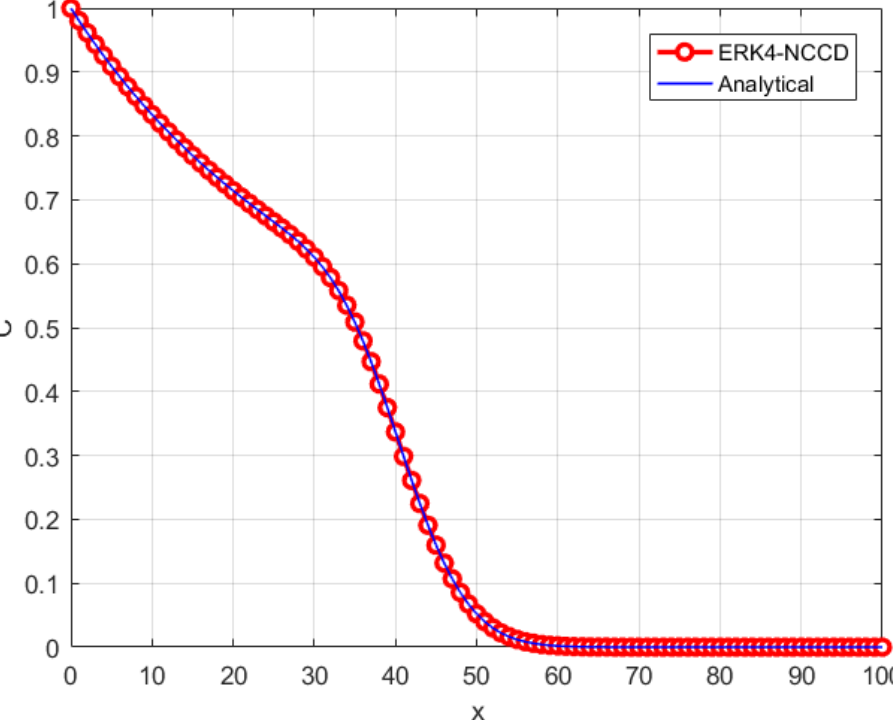
Figure 2. Analytical and numerical solution of the ADE with spatially variable parameters at t = 3000 s for ∆ t = 1 s and ∝= 0.02 m −1 .